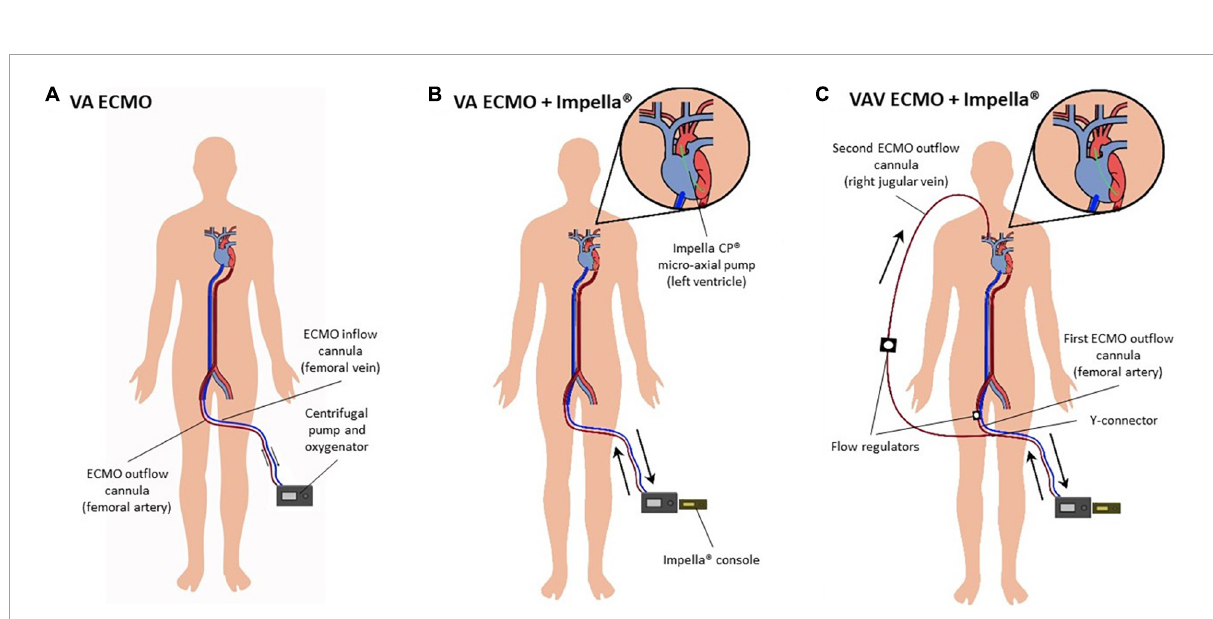
FIGURE2 (A–C) Diagram on configurations of percutaneous mechanical circulatory support devices. (A) Peripheral VA ECMO. Poorly oxygenated blood is drawn from the femoral vein, oxygenated in a membrane oxygenator and returned by a centrifugal pump via the common femoral artery. (B) VA ECMO and Impella R (cid:13) pump (“ECMELLA”). The Impella R (cid:13) pump is placed across the aortic valve to provide continuous blood flow from the LV into the proximal ascending aorta. (C) VAV ECMO and Impella R (cid:13) . VAV ECMO is a triple cannulation technique by “upgrading” the VA ECMO configuration. A third cannula is inserted into the jugular or subclavian vein. The ECMO outflow with oxygenated blood is diverted into two cannulas by a Y-connector, one cannula toward the aorta via the common femoral artery and one toward the right atrium via the jugular or subclavian vein. Flow regulators control blood flow into the arterial and venous circuit, respectively. Abbreviations: left ventricle (LV); veno-arterial extracorporeal membrane oxygenation (VA ECMO); veno-arterio-venous ECMO (VAV